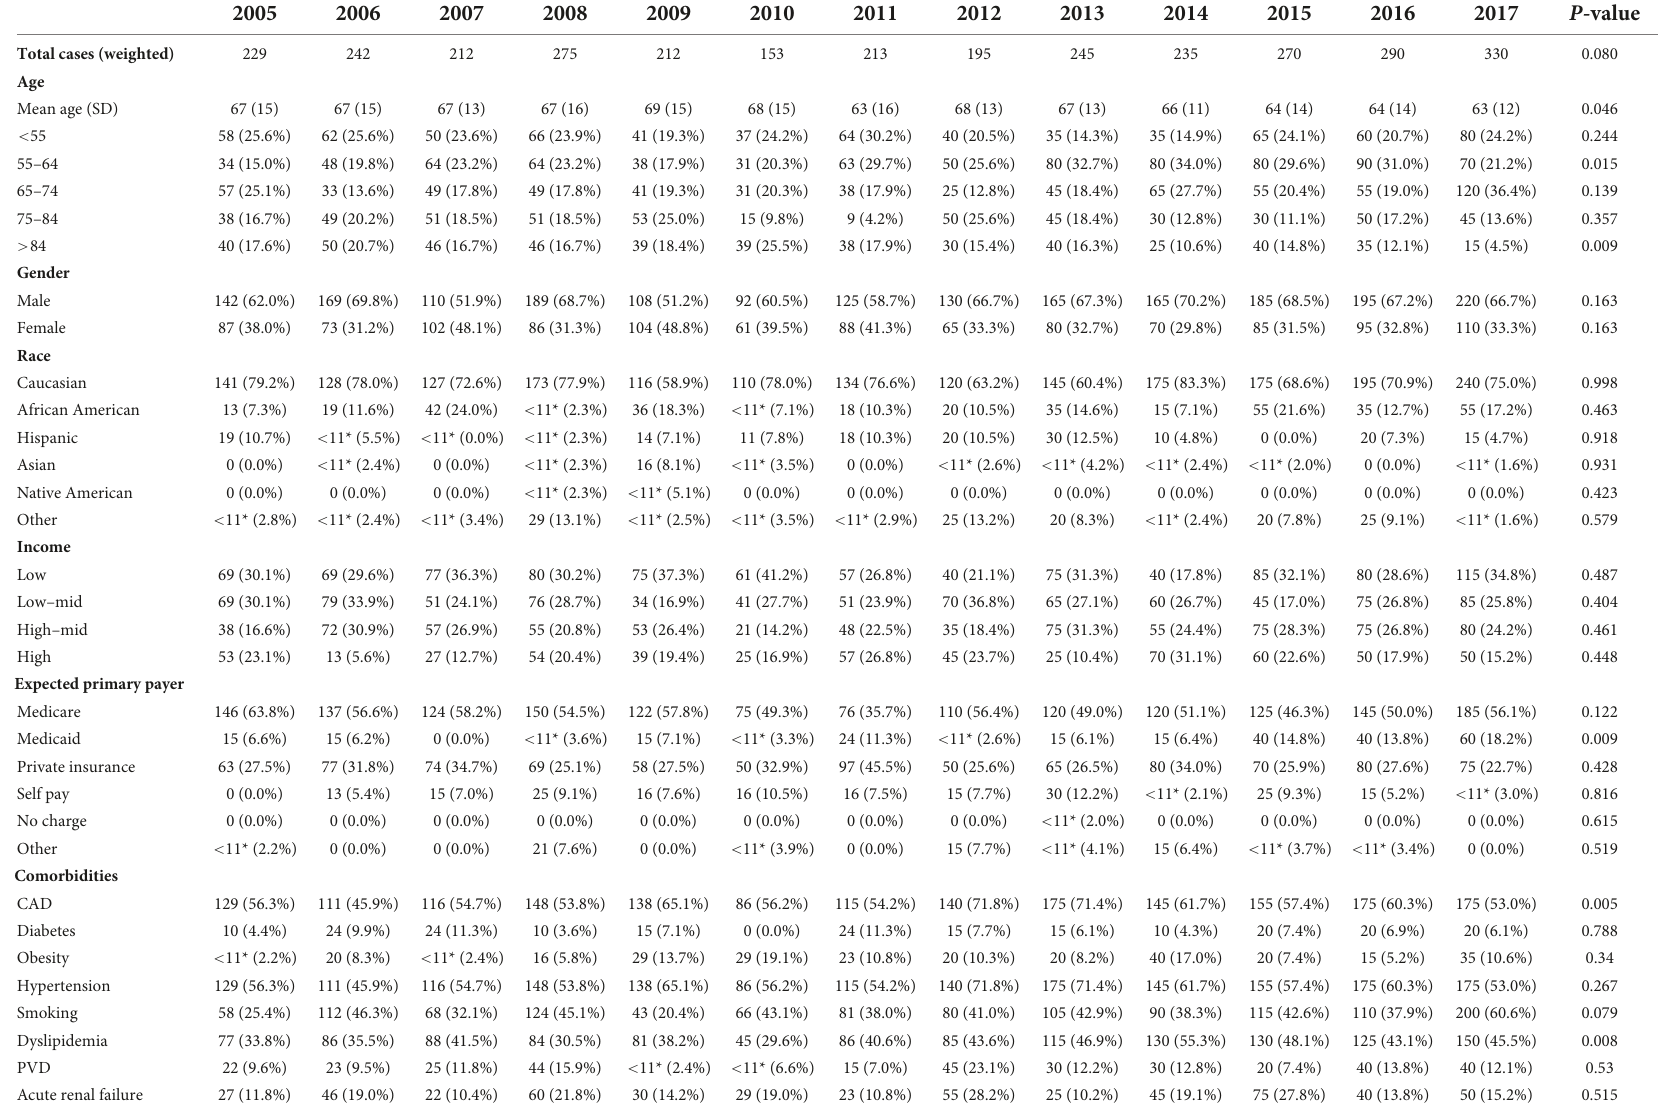
TABLE 1 Baseline characteristics, outcomes, and temporal trend of patients hospitalized for STEMI with a secondary diagnosis of hypoglycemia in the NIS database, between 2005 and